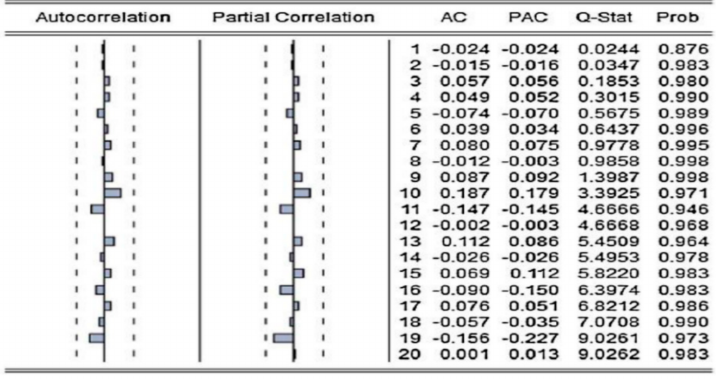
Figure 2. The correlogram of the residual error of the LT-ARIMAXS model (2,1,2). Note: Columns 1 and 2 show the velocity trend of the correlation coefficient that shrank to two times the standard deviation (obtained by EViews). AC is the value of the autocorrelation coefficient. PAC is the value of the partial correlation coefficient. Q-stat denotes the Q test statistic method at time t − i